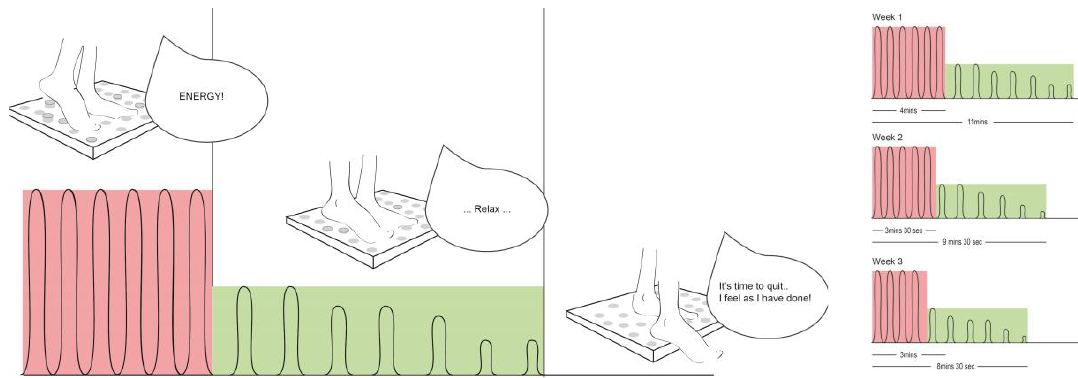
Figure 6. F.E.E.L.: a temporal choreography of sensory stimulation in the floor is associated with the user’s routine after which the routine is gradually reduced in time, thereby reducing water consumption (illustration © Sara Bergamaschi).